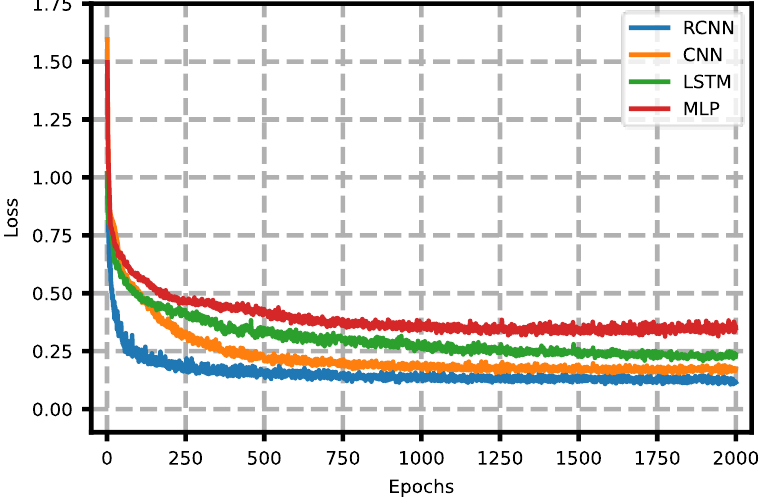
Figure 11. Loss comparison of the validation data sets among different learning models.